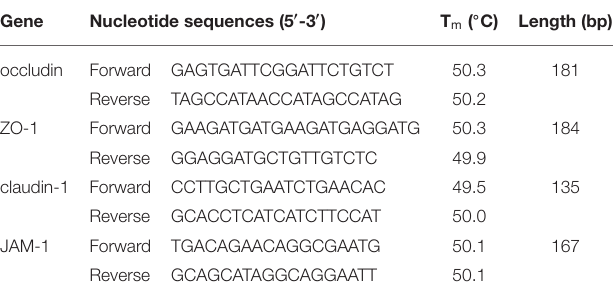
TABLE 1 | Primer sequences for Q-RT-PCR.